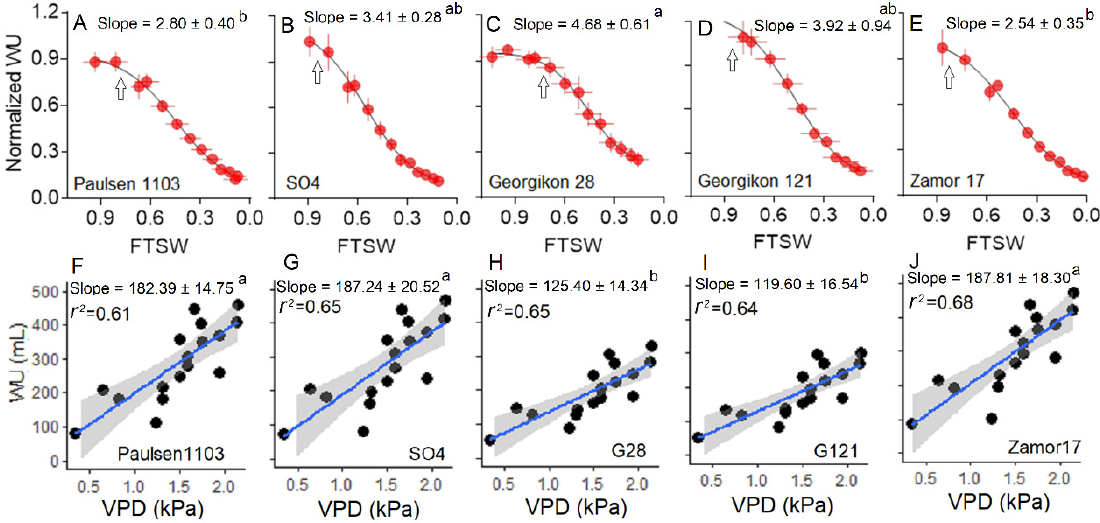
Figure 4. Plots of normalized water use (between 0 to1) to FTSW for each rootstocks ( A – E ). Error bars represent standard error of the means (SEM, n = 6–9). Data for estimated values from logistic fit are shown in the graphs and slope was significant ( p = 0.021) according to one-way ANOVA and different letters represent significant differences according to Fisher’s test. Arrows represent the level of FTSW at which WU was reduced. ( F – J ) Relationship between WU and VPD for all the rootstocks. The slope and r 2 for each linear fit are shown in the graph and the slope of the regression was significantly different ( p = 0.008, n = 6–9) according to one-way ANOVA. Different letters represent significant differences according to Fisher’s test. Grey area represents confidence interval.